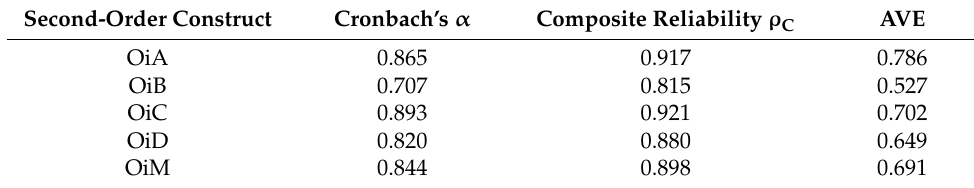
Table 4. Reliability and validity assessment of the second-order model.